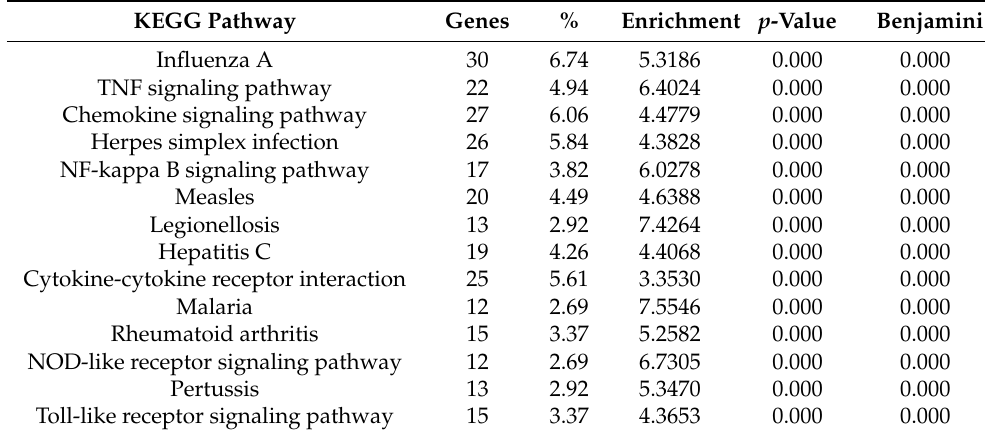
Table 2. Enriched gene ontology terms of the transcripts in M.BCG compared against the control. M.BCG: Mycobacterium bovis Mexico.